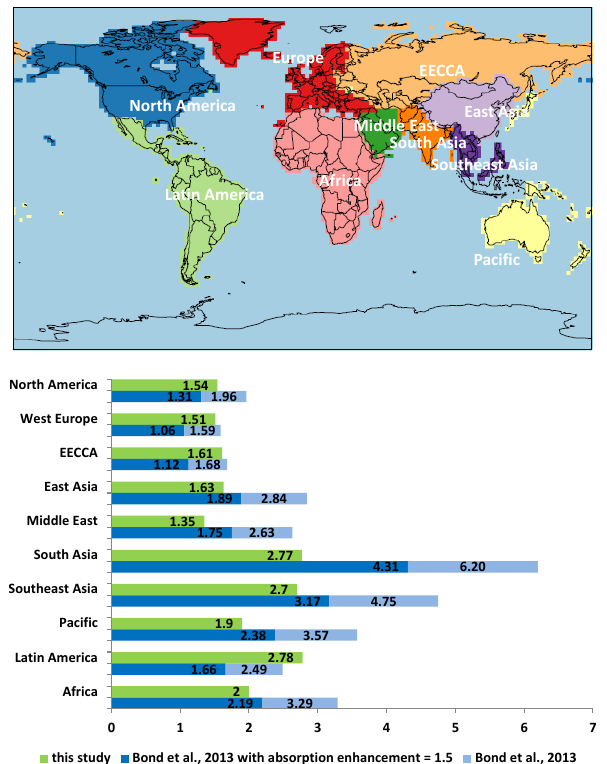
Figure 9. Top: region groups defined in Sect. 5 based on Supple- ment Table S1 in Bond et al. (2013). EECCA = eastern Europe, the Caucasus and Central Asia. Bottom: the ratio of mean regional AERONET AAOD to “best” modeled AAOD (green, average value over selected AERONET sites in Sect. 5.2) and mean regional AERONET AAOD to mean regional AeroCom I AAOD (light blue, average value over selected AERONET sites defined in Bond et al., 2013). The bar with dark blue indicates the ratios when an absorp- tion enhancement of 1.5 was uniformly